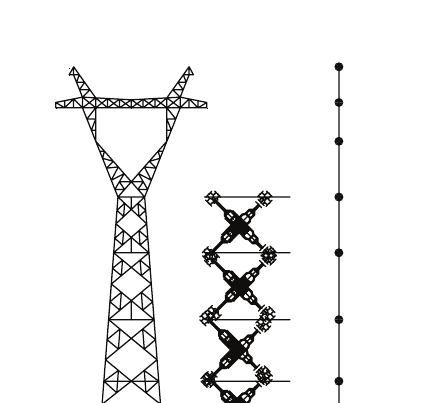
Figure 13: Ice-shedding scenarios.